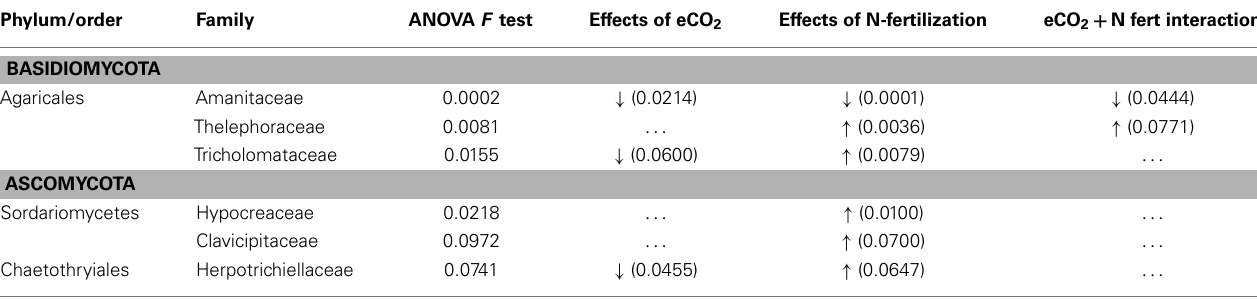
Table 6 | Basidiomycota andAscomycota families showing significant differences in representation in LSU 454 pyrosequence libraries in the 0–2cm soil depth interval, under long-term elevated atmospheric CO 2 conditions, N-fertilization, or the combination of